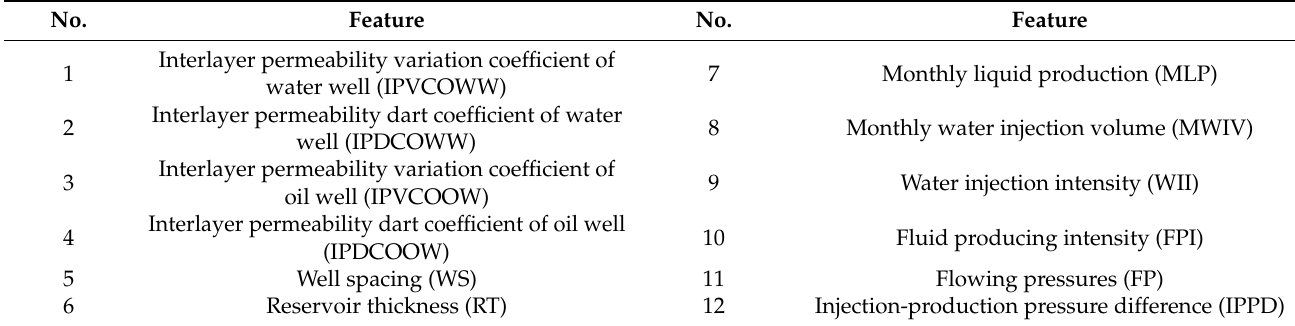
Figure 5. Pearson’s correlation coefficient for data set D. Table 3. Optimal feature